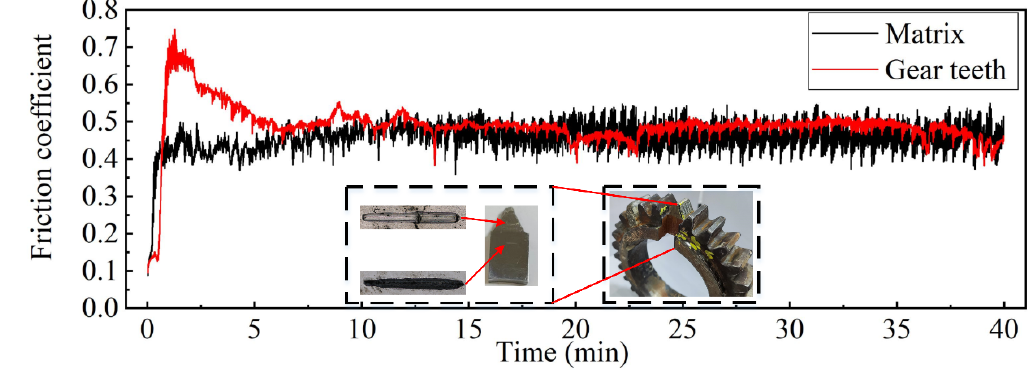
Figure 17. The friction coefficient of the substrate, Ni-based coating.